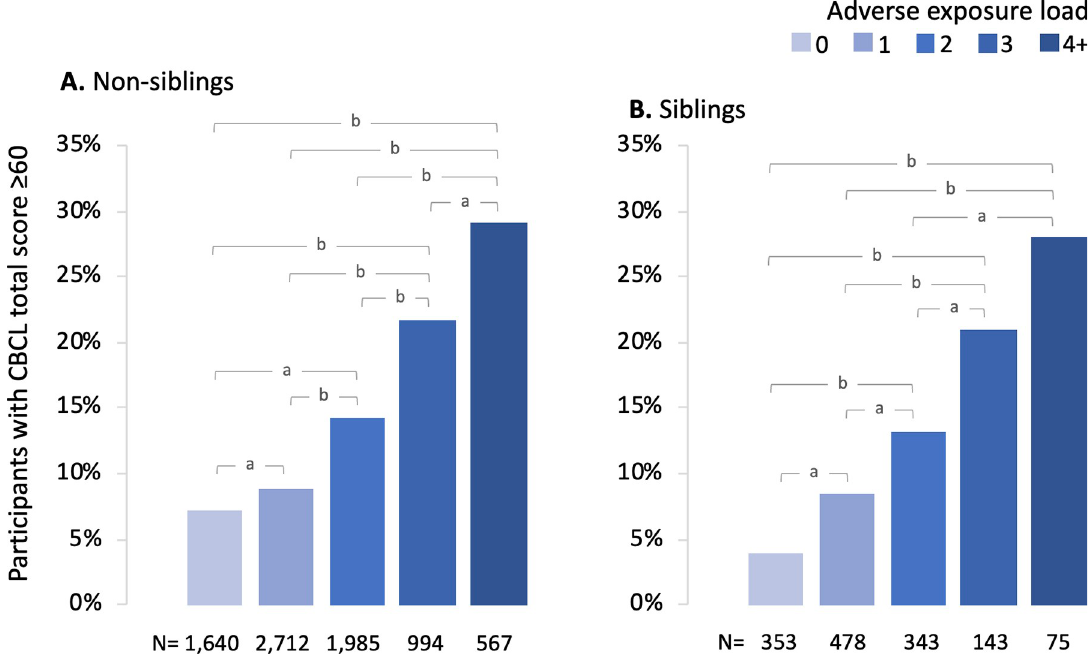
Fig 1. Frequency of CBCL total score above the normal range ( � 60) as related to adverse prenatal exposure load. a, p < .05; b, p < .001 for pairwise differences in odds of CBCL total � 60 in fully adjusted